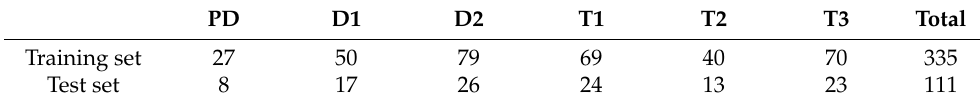
Table 6. Dataset samples per each fault type for training and testing sets. PD D1 D2 T1 T2 T3 Total Training set 27